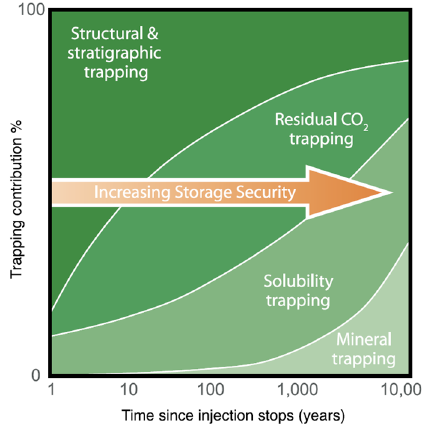
Figure 1. Underground CO 2 storage mechanisms and security [6].